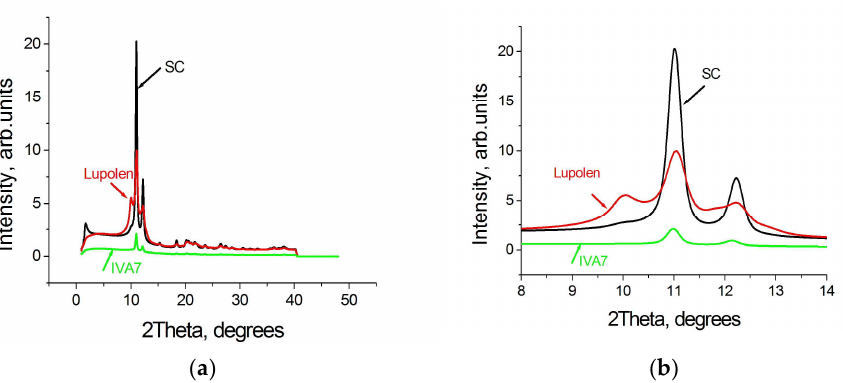
Figure 2. WAXS curves of the virgin individual UHMWPE RP particles: Lupolen (red), SC (black), and IVA7 (green) shown for a range 40 degrees ( a ) and 6 degrees ( b ). Along with 110 and 200 orthorhombic reflections, an intense monoclinic peak 001 is resolved in the WAXS pattern of the Lupolen powder, is noted in the WAXS pattern of the SC powder, and is practically undetected in the WAXS pattern of the IVA7 powder. (The difference in the intensities is caused by the various particle sizes selected for in- vestigation).